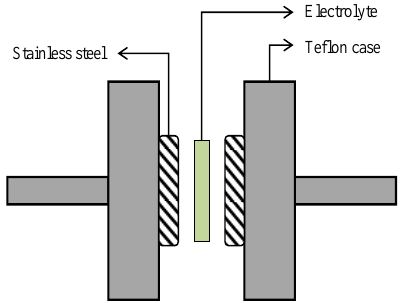
Figure 1. Schematic illustration of the electrolyte–electrodes arrangement for TNM and LSV